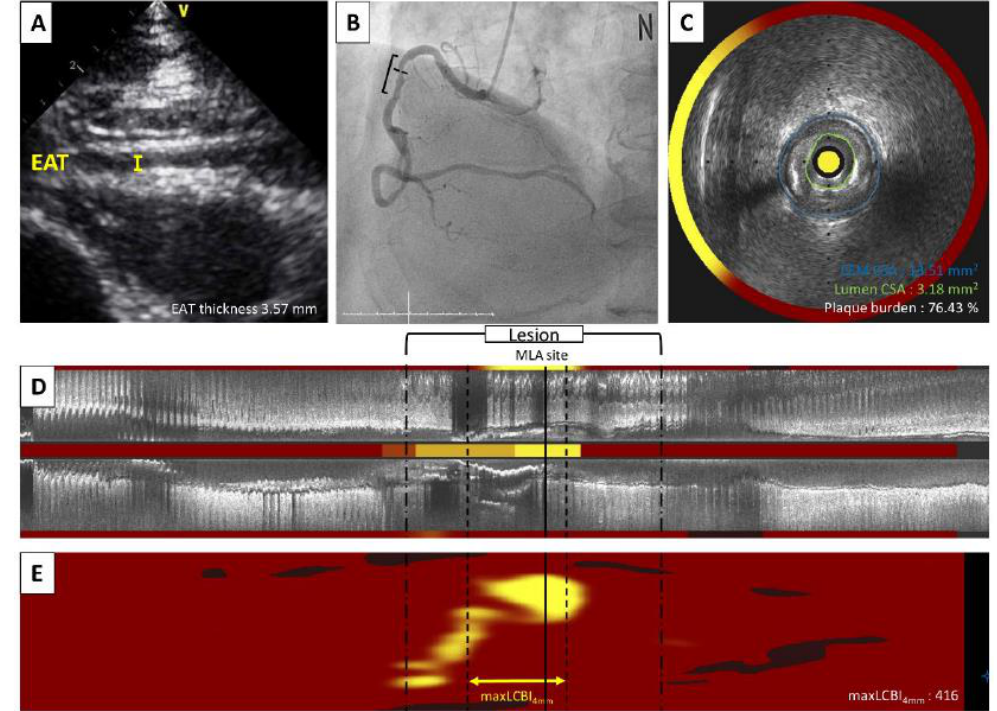
Figure 2. A representative case of a 68-year-old patient with unstable angina was evaluated by echocardiogram and NIRS-IVUS imaging. ( A )Transthoracic echocardiography revealed EAT was 3.57 mm. ( B ) Right coronary artery has an intermediate stenosis at proximal part. ( C ) Cross-sectional NIRS-IVUS image showed 3.18 mm 2 in lumen area, 76.4% of plaque burden and a quarter of yellow color in circumferential chemogram at the MLA site. ( D ) Longitudinal image with block chemogram and ( E ) color-coded map revealed a lipid rich plaque (yellow) with 416 max LCBI 4mm . CSA, cross sectional area; EAT, epicardial adipose thickness; EEM, external elastic membrane; IVUS, intravas- cular ultrasound; max LCBI 4mm , maximum lipid core burden index in any 4 mm segment; MLA, min-